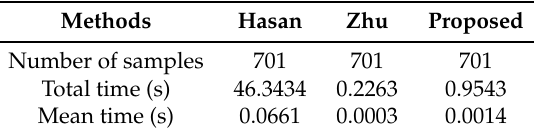
Table 2. Running time of